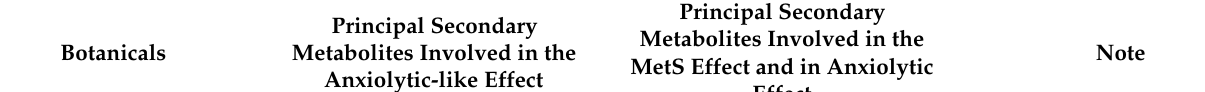
Table 1. Summarizes the information for the use of selected botanicals in MetS and anxiety.